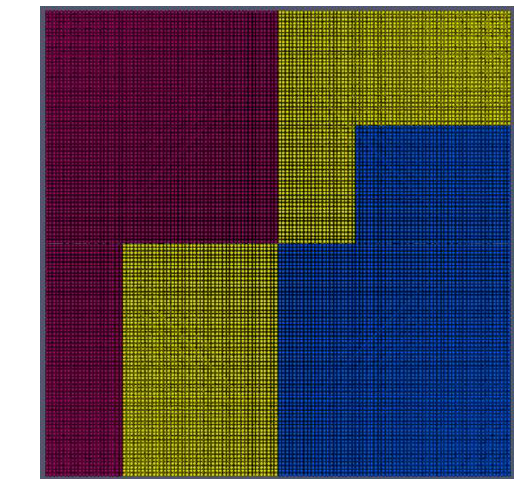
Figure 4. Communication: data transferred between ( a ) cores and ( b ) nodes.